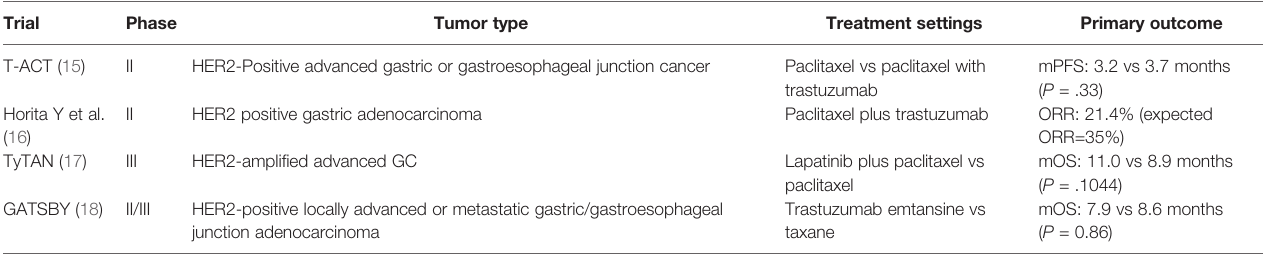
TABLE 1 | The previous clinical trials of second-line treatment for